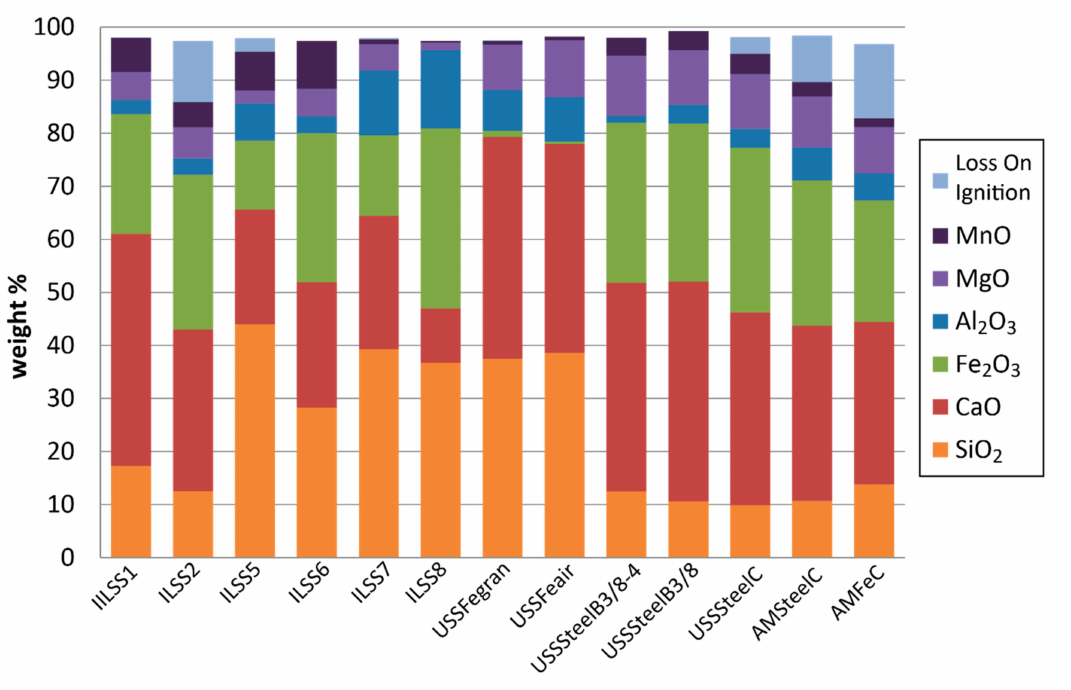
Figure 2. Major element chemistry and loss on ignition for modern and legacy steelmaking slag samples from the Chicago-Gary area, Illinois and Indiana, determined by wavelength dispersive X-ray fluorescence spectroscopy